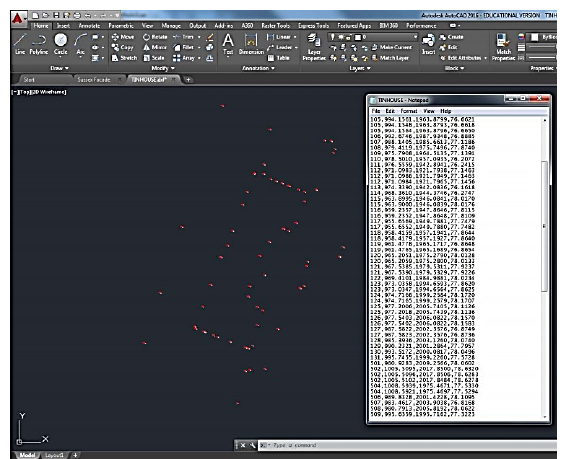
Figure 3: Surveyed points in CAD environment, and their respective coordinates.